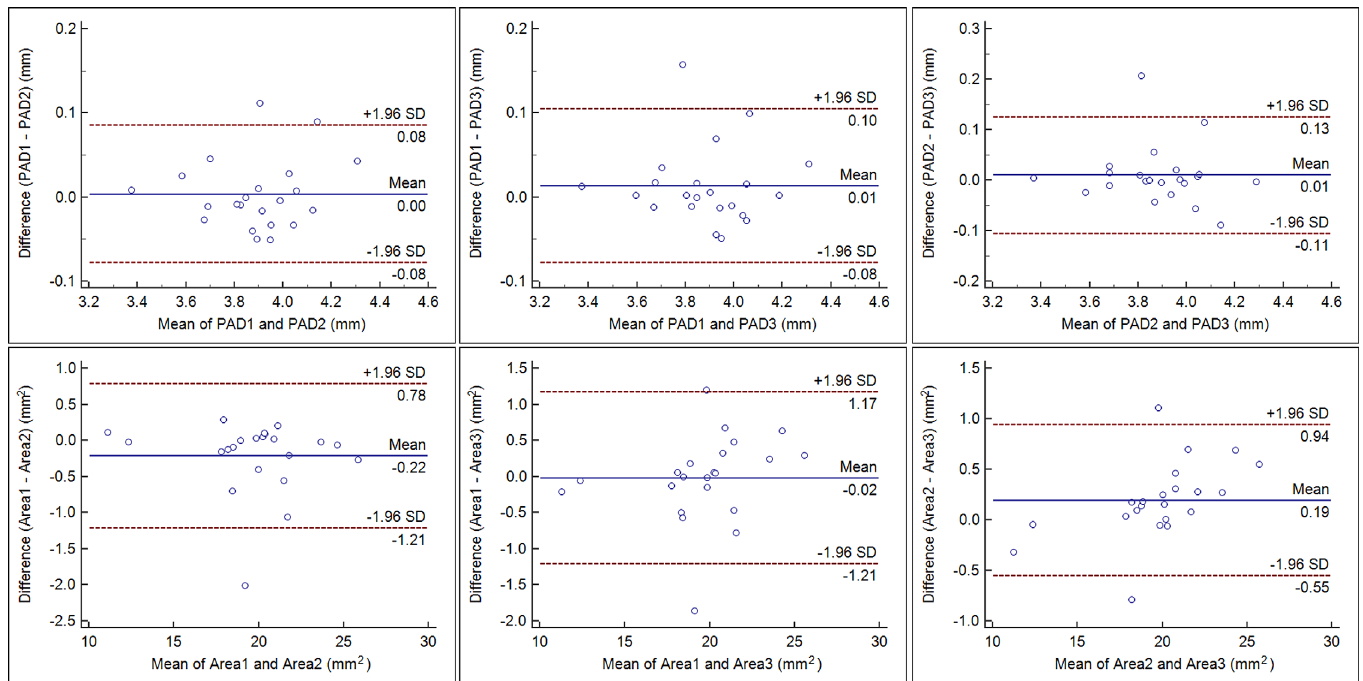
Fig 5. Bland-Altman plots showing three continuous measurements comparisons of postoperative aqueous depth (PAD) and anterior capsulorhexis area (Area). The solid line indicates the mean difference (bias). The upper and lower lines represent the 95% limits of agreement (LoA).